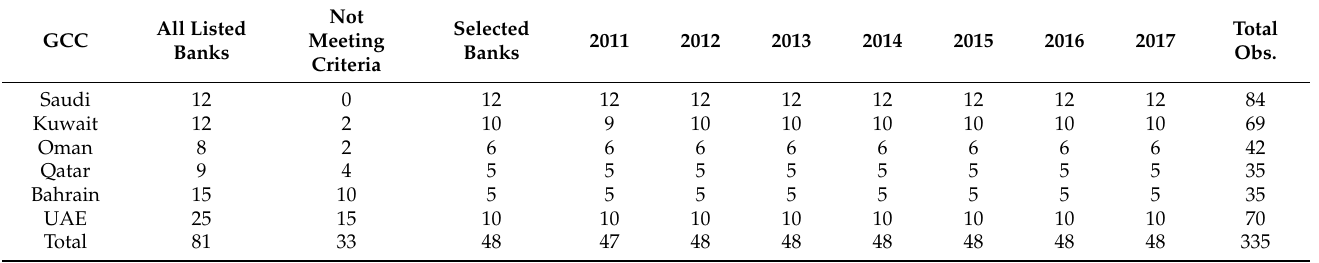
Table 1. Selected